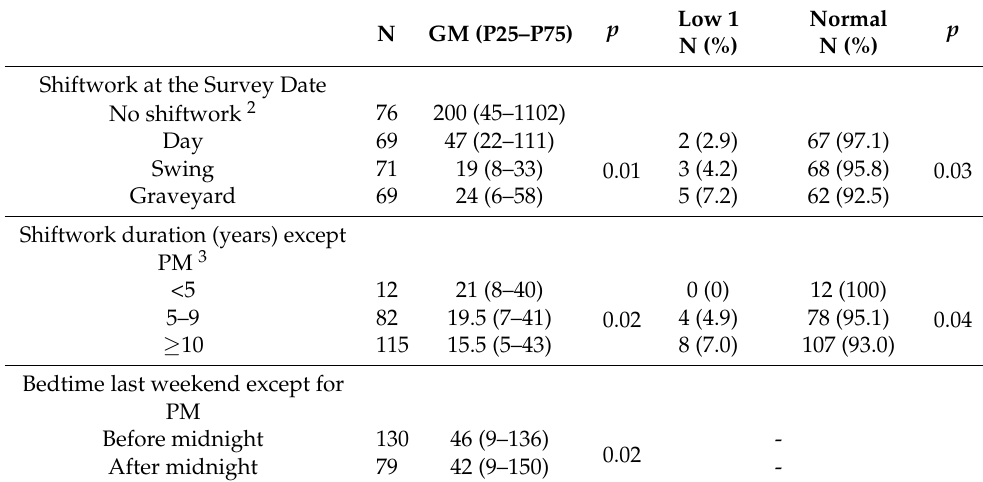
Table 4. The detection rate of the urinary 6-hydroxymelatonin sulfate levels for semiconductor workers according to the shiftwork and the